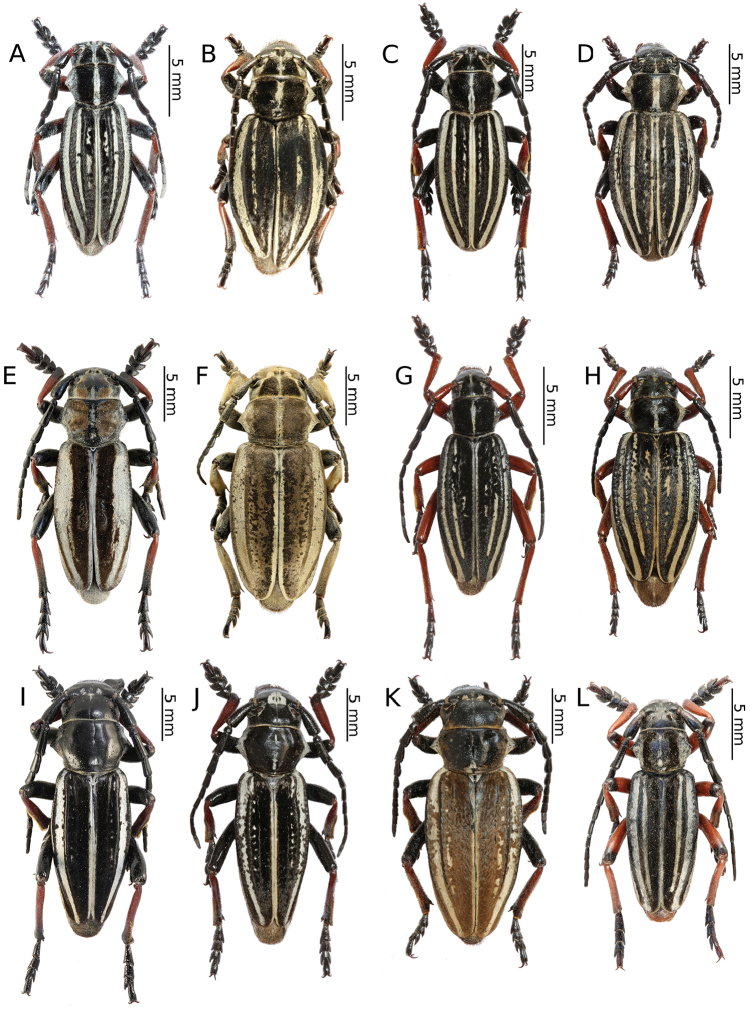
Photos of longhorn beetles specimens collected during the expedition to Kazakhstan in 2017: ADorcadionabakumovisarkandicum (male) BD.abakumovisarkandicum (female) CDorcadiontenuelineatum (male) DD.tenuelineatum (female) EDorcadioncrassipescrassipes (male) FD.crassipescrassipes (female) GDorcadionacutispinum (male) HD.acutispinum (female) IDorcadiongeblerigebleri (male, Zaysan environs) JD.geblerigebleri (male, Kabanbay environs) KD.geblerigebleri (female) LDorcadionarietinumarietinum (male).